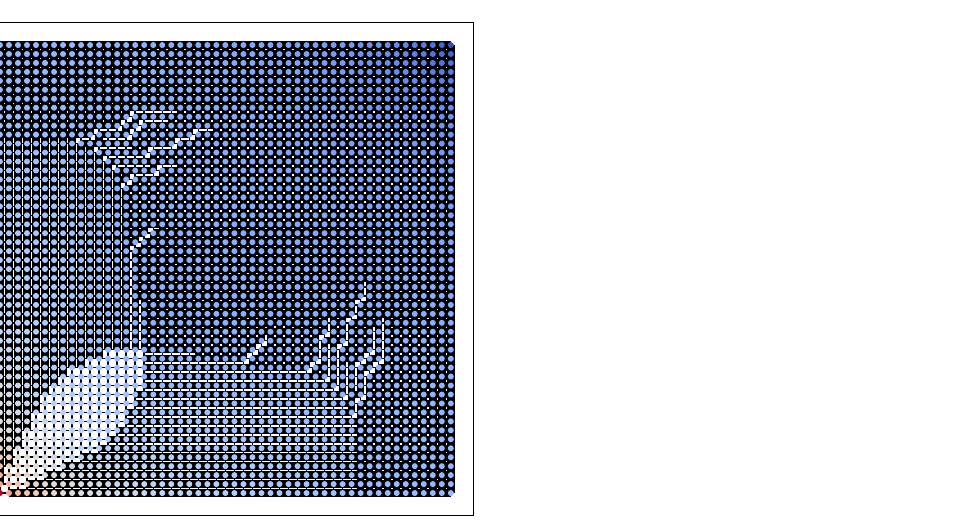
Figure 4. Approximately optimal design for m = 51 .